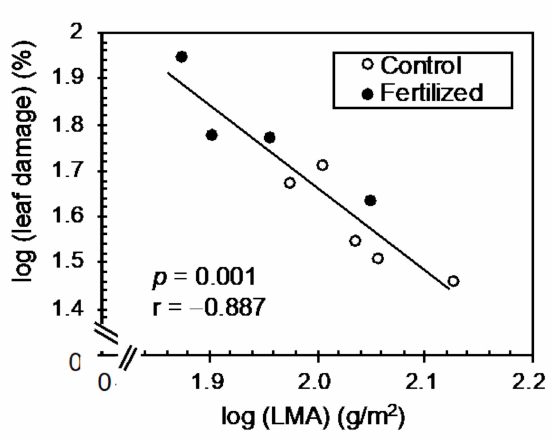
Figure 3. Pearson’s correlation between the LMA and leaf damage by chewers in late 2014. Circles in white and black indicate control and fertilized trees, respectively. Regression results and the line of best fit are